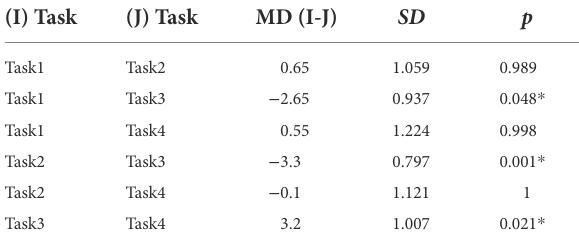
TABLE 5 Multiple comparisons between Task1/2/3/4 within the ESVD